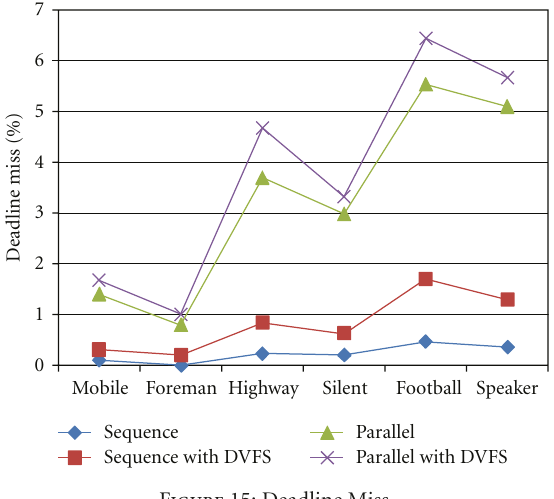
Figure 15: Deadline Miss.